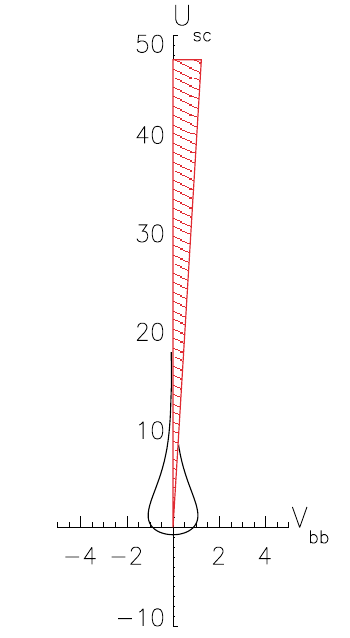
FIG. 1. (Color) The stability boundary provided by linear Lan- dau damping (solid black line) together with the area (red) of “stabilization due to space charge induced mode